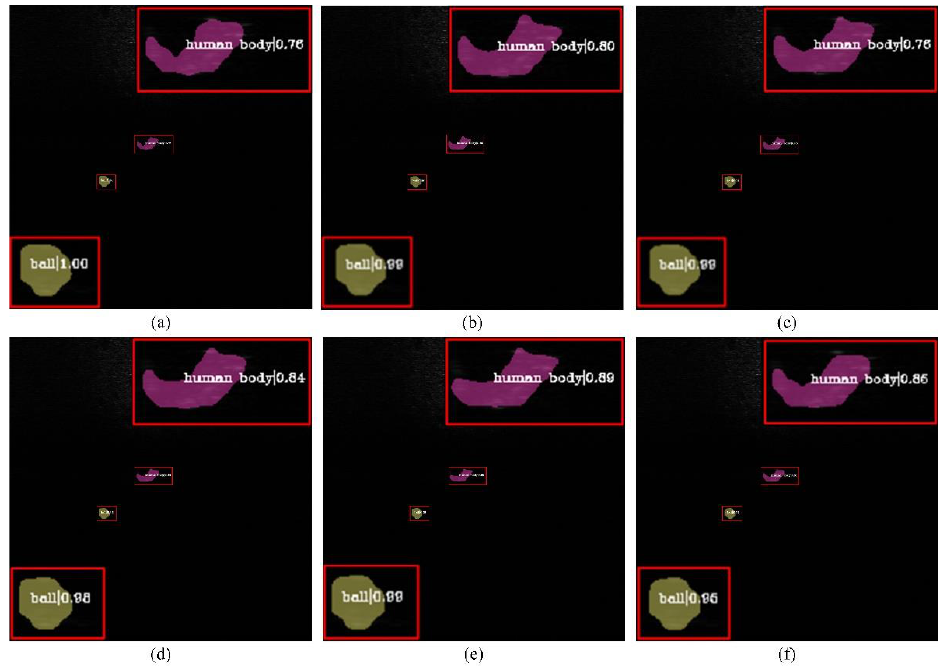
Figure 6. The results of different values of n and the different positions of GF-PSA. ( a – c ): the GF-PSA is embedded between the ResNet and FPN; ( d – f ): the GF-PSA is embedded after FPN. ( a , d ) n = 2; ( b , e ) n = 4; ( c , f ) n = 8.